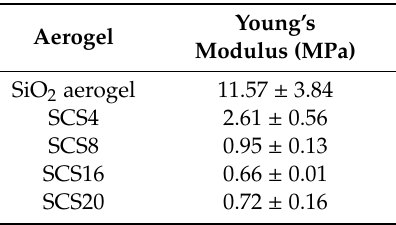
Table 3. Young’s elastic modulus values of the outlined